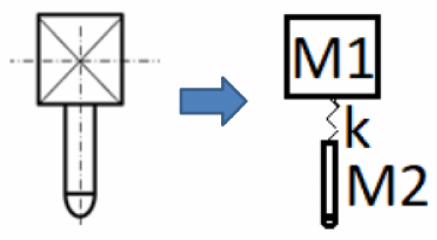
Figure 8. Proposed 2DOF model for the impactor system: simplified finite element model data representation.